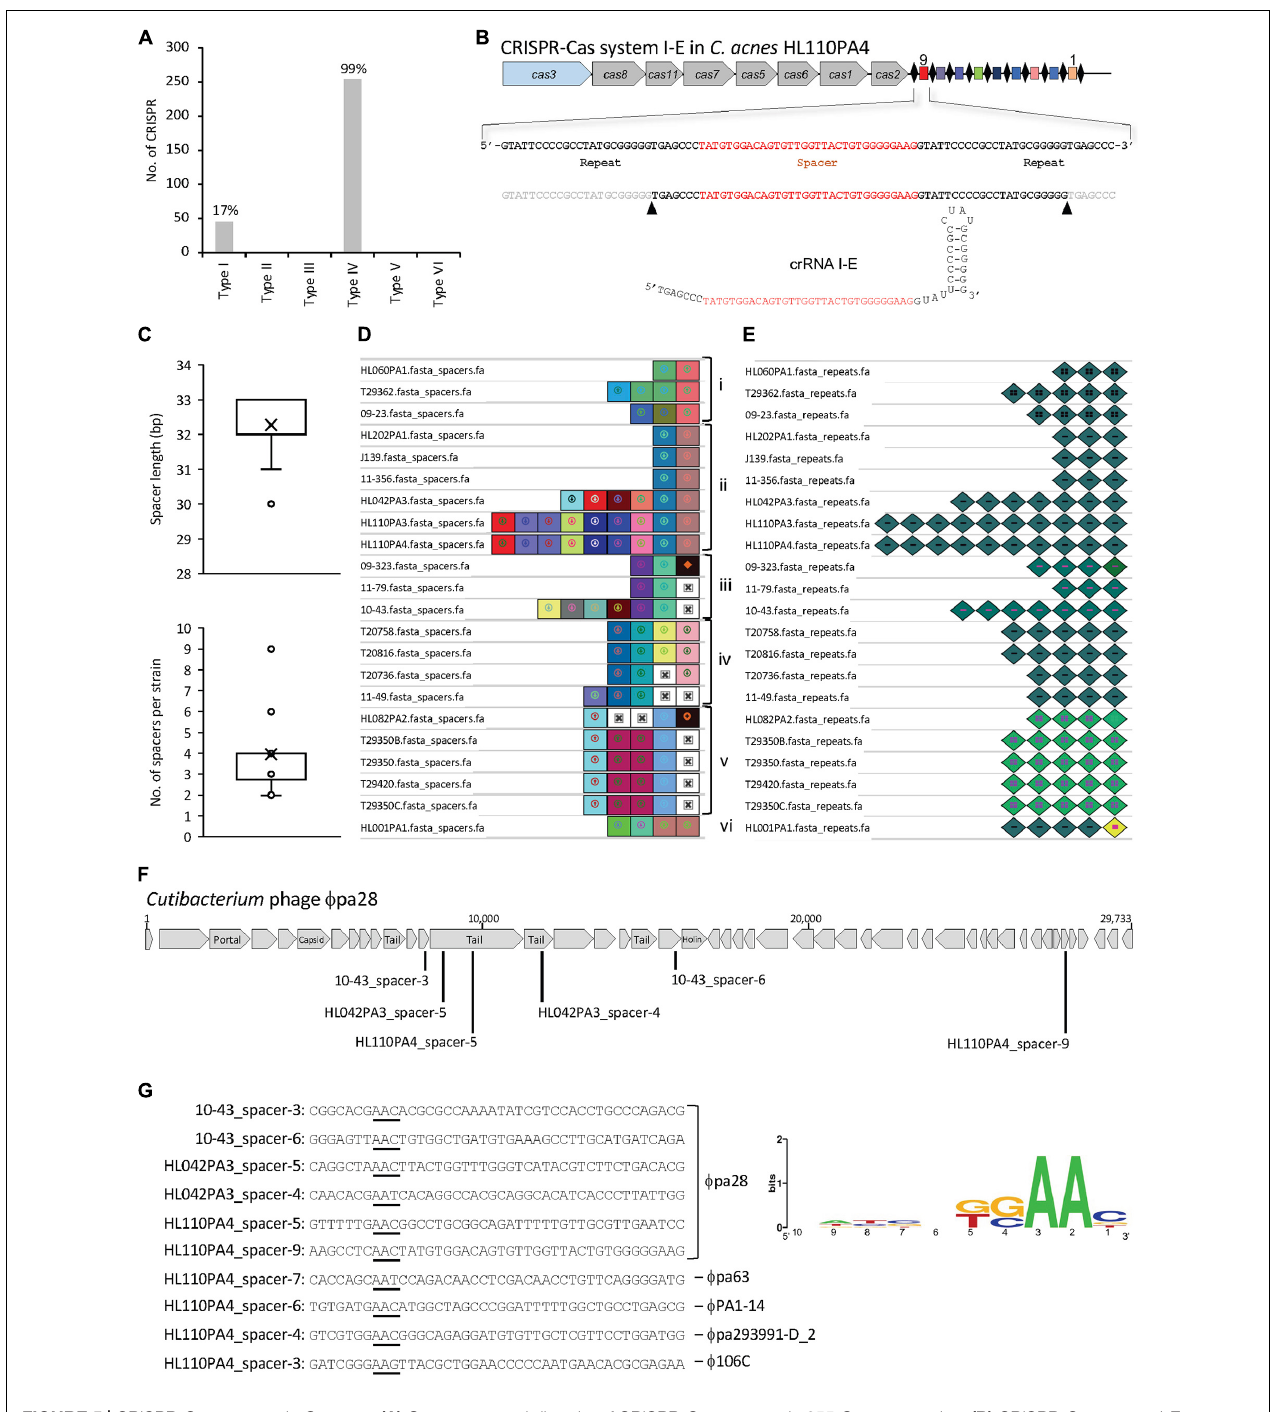
FIGURE 5 | CRISPR-Cas systems in C. acnes . (A) Occurrence and diversity of CRISPR-Cas systems in 255 C. acnes strains. (B) CRISPR-Cas system I-E displaying a canonical profile with signature cas3 gene colored in blue, Cascade in gray, CRISPR array with the repeats as black diamonds and the spacers as colored squares; with the mature CRISPR RNA (crRNA) displaying the hairpin structure on the bottom. (C) Distribution of the spacer length and number of spacers per strain. (D) Visualization of the CRISPR spacers with unique colors and shapes for each unique spacer sequence, aligned based on nucleotide identity for genotyping purposes, with the oldest spacer (ancestor) on the right and the most recently acquire spacer on the left. Groups of strains based on CRISPR spacers-genotyping are labeled from i-vi. (E) Visualization of the CRISPR repeats with unique colors and shapes for each unique repeat sequence. Mutated terminal repeats (corresponding to the ancestor) were identified. (F) Schematic representation of the Cutibacterium phage φ pa28 targeted by several CRISPR spacers of various C. acnes strains. (G) Protospacer sequences (targeted by CRISPR spacers) with the corresponding protospacer adjacent motif (PAM) on the 5 (cid:48) -end underlined, and representation of the PAM conservation (right